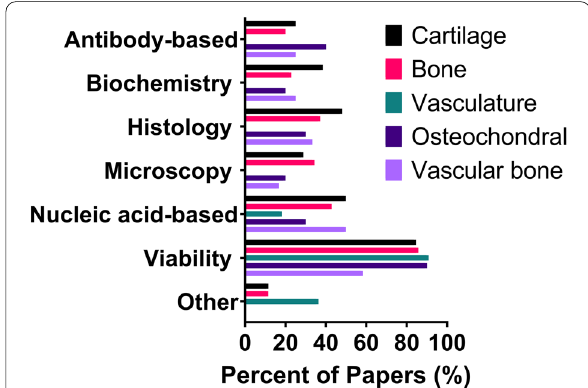
Fig. 4 In vitro testing methods reported in papers from each construct